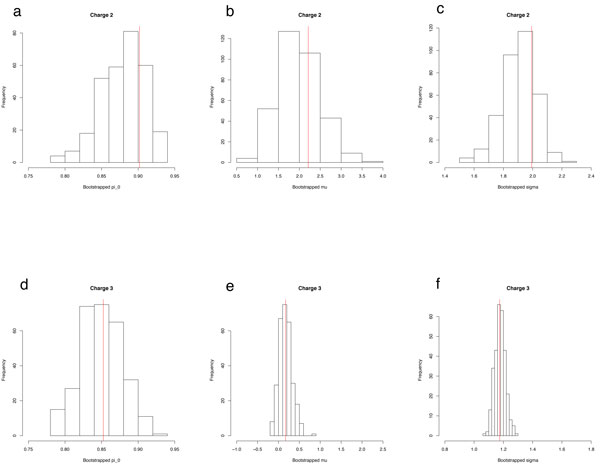
Bootstrapped samples of π0, μ , and σ for Charges 2 and 3 of the Human Plasma data. The original estimates are marked by the vertical line. The length of the horizontal axes are equal for the plots of a particular parameter. The Charge 2 distributions are slightly skewed compared to Charge 3 distributions and the mean squared errors are much greater in Charge 2 distributions. The variability of the Charge 2 distributions are visibly much greater indicating unstable estimates.